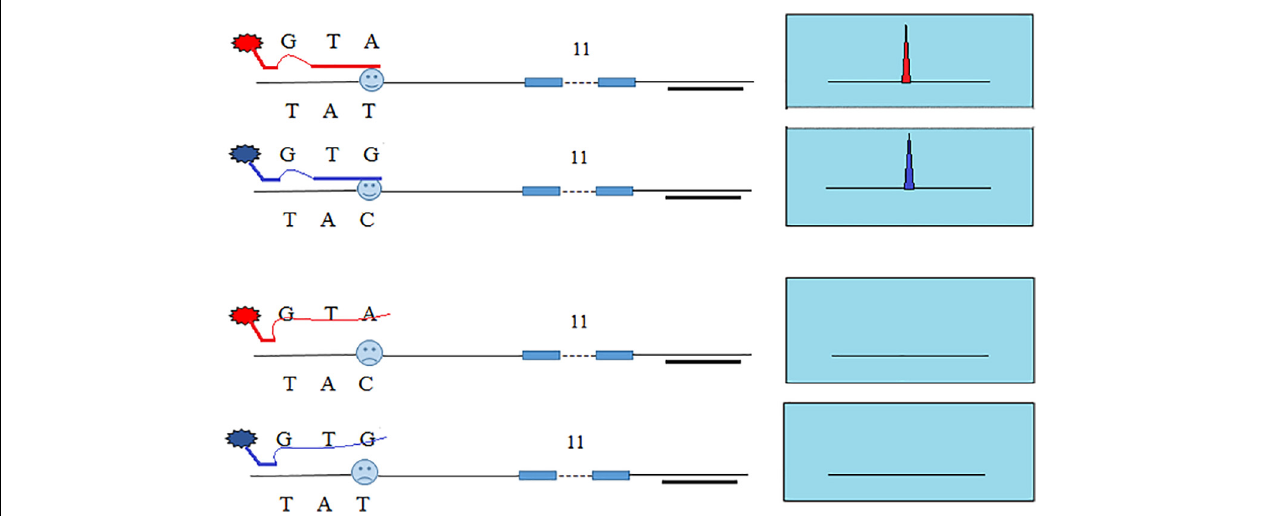
FIGURE 1 | The principle of allele-specific primer design for SNP-STR markers using the ARMS technique. Each of the two allele-specific SNP primers is labeled with different fluorescent dyes. The common reverse primer is located downstream of the STR core region sequence. The obtained allele peaks are detected using capillary electrophoresis (CE), with the resultant product peaks containing two genotypes: (1) the color represents the SNP allele; (2) the size corresponds to the STR